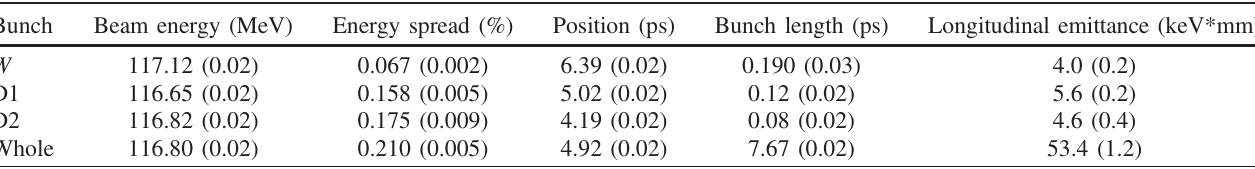
TABLE II. Beam parameter for longitudinal phase space B in Fig. 2.